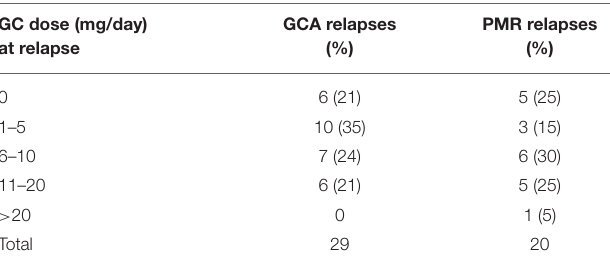
TABLE 2 | Daily glucocorticoid dose use at the time of relapse for GCA ( N = 24) and PMR ( N = 21) patients. GC dose (mg/day) at relapse